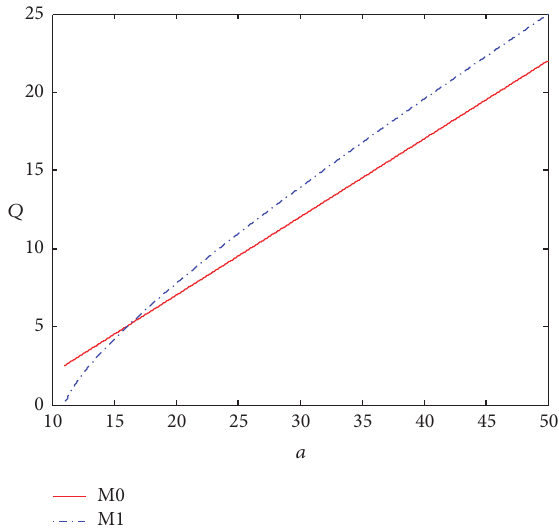
Figure 2: Optimal order quantity comparison in models M0 and